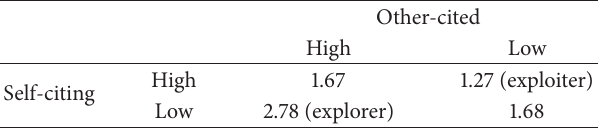
Table 3: The statistical means for the market-to-book-ratio with respect to the four situations composed of the two self-citing and other-cited